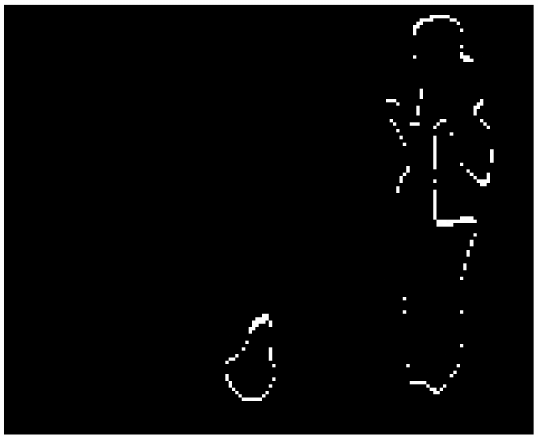
Figure 4. The pixel movement of the image.